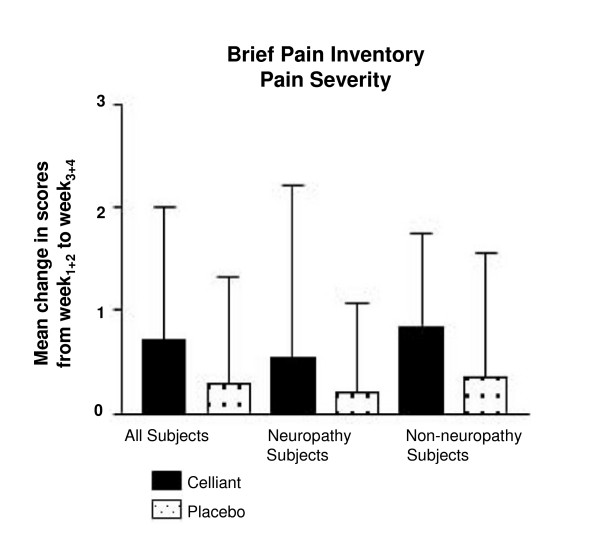
Results of the Brief Pain Inventory – Pain Severity. The difference between mean W1+2 and mean W3+4 scores is depicted. Solid bars report Celliant™ and stipled bars report control subjects.